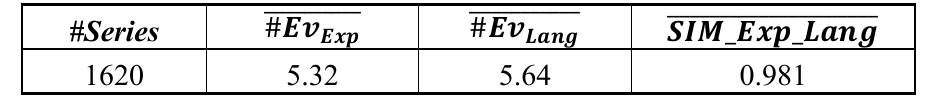
Table 9. Global results of the application of the events definition language to the stabilometric domain.